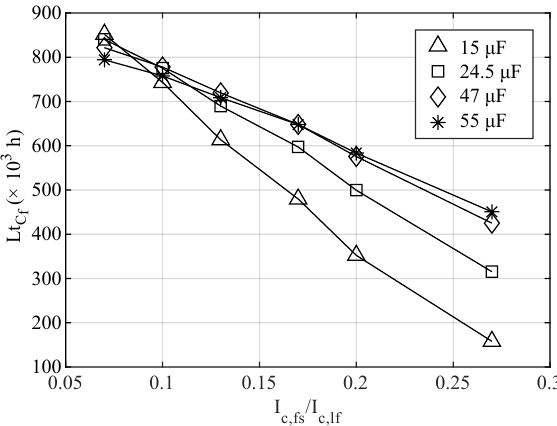
Figure 7. Estimated lifetime for C f ( Lt C